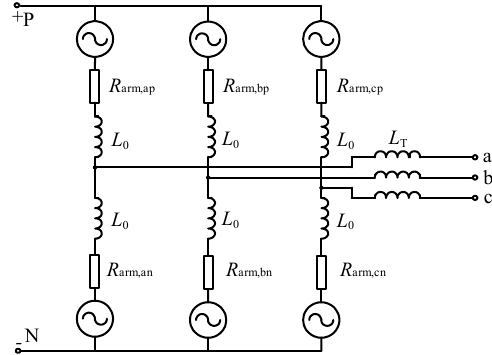
Figure 5. Equivalent circuit of an modular multilevel converter (MMC).